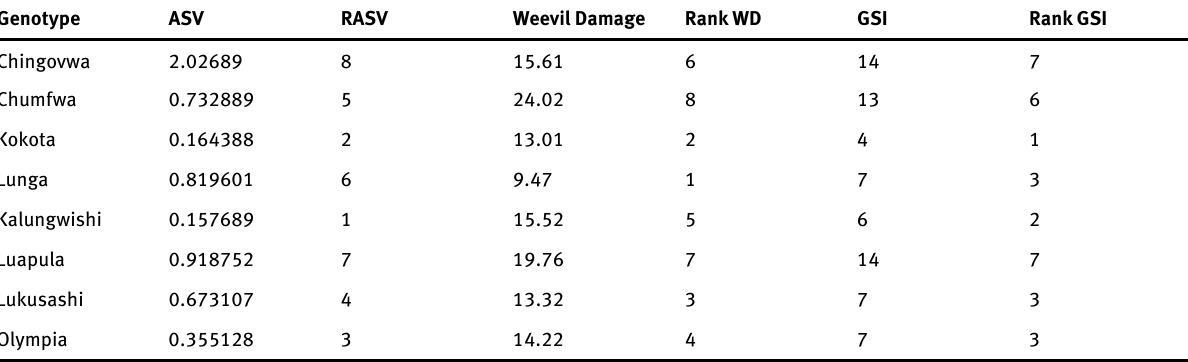
Table 5: Ranked genotype selection indices for sweetpotato weevil damage Genotype